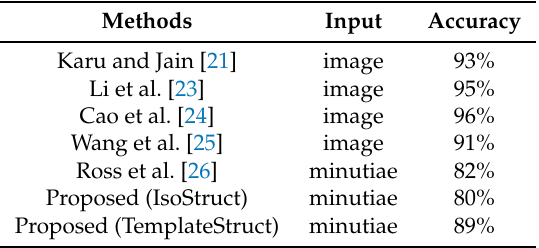
Table 12. Comparison with methods from the state of the